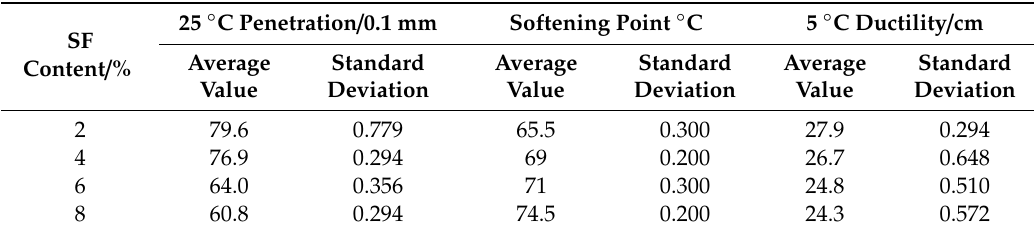
Table 4. The technological indexes of modified asphalt with di ff erent mixing